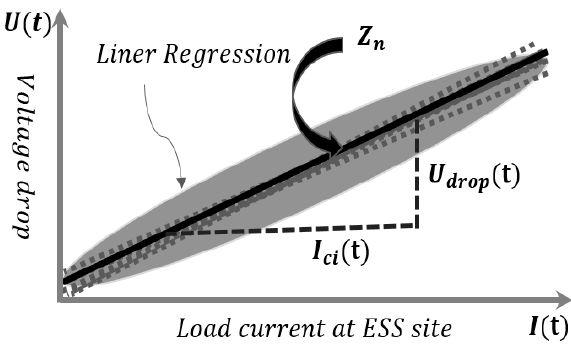
Figure 3. Distribution characteristics of line impedance.